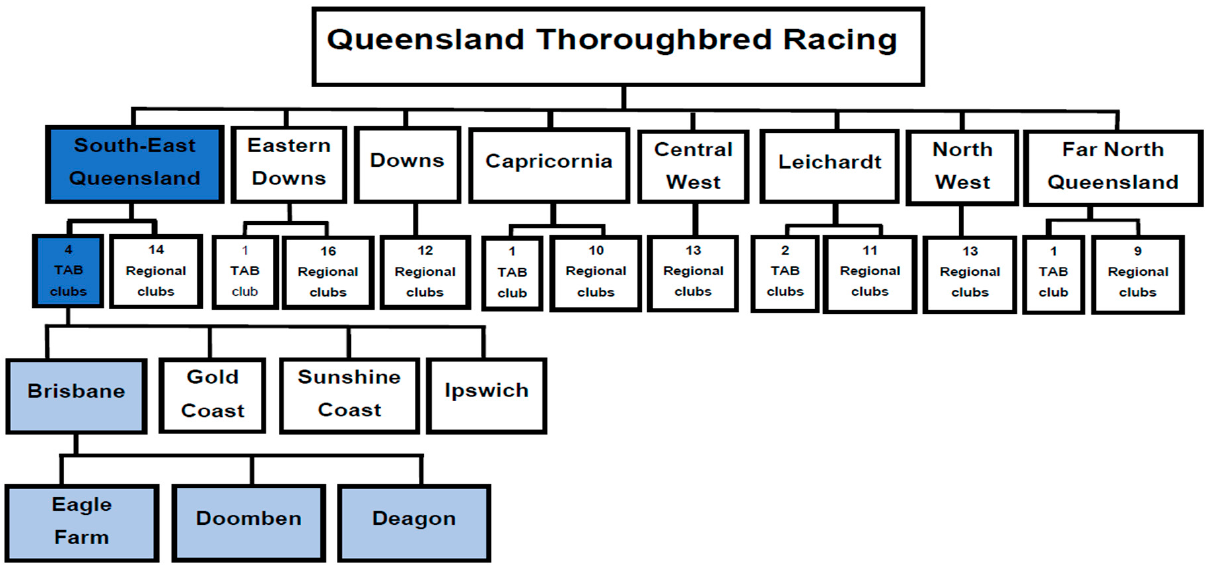
Figure A1. A summary of the Thoroughbred racing industry in Queensland. Totalisator Agency Board (TAB) and regional (non-TAB) clubs for each region are illustrated. The target population for this study is the TAB clubs of South-East Queensland (dark blue). The sampling frame is Brisbane Racing Club (light blue).